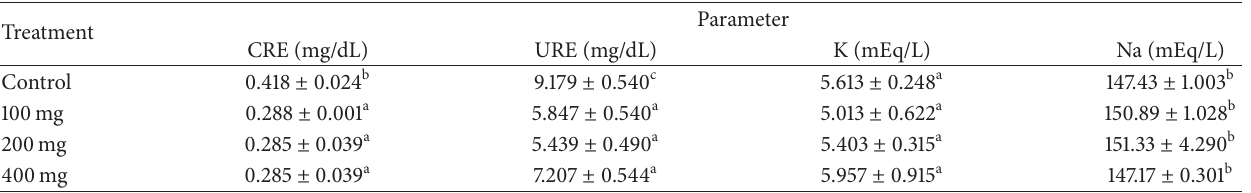
Values are expressed as mean ± SEM. Rows with different superscript show significant difference ( 𝑝 < 0.05